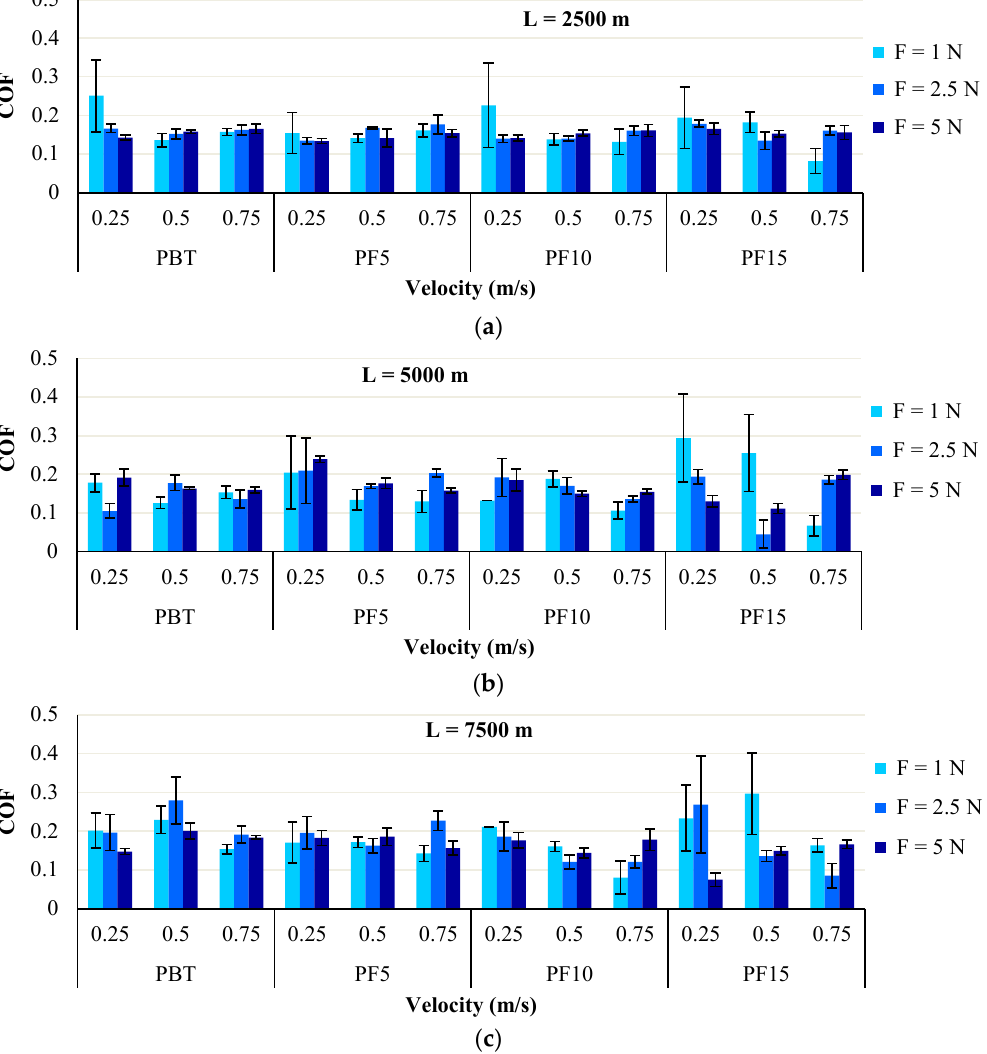
Figure 7. Average values of friction coefficient (COF), with standard deviation for tested materials, calculated for different sliding distances: ( a ) L = 2500 m; ( b ) L = 5000 m; ( c ) L = 7500